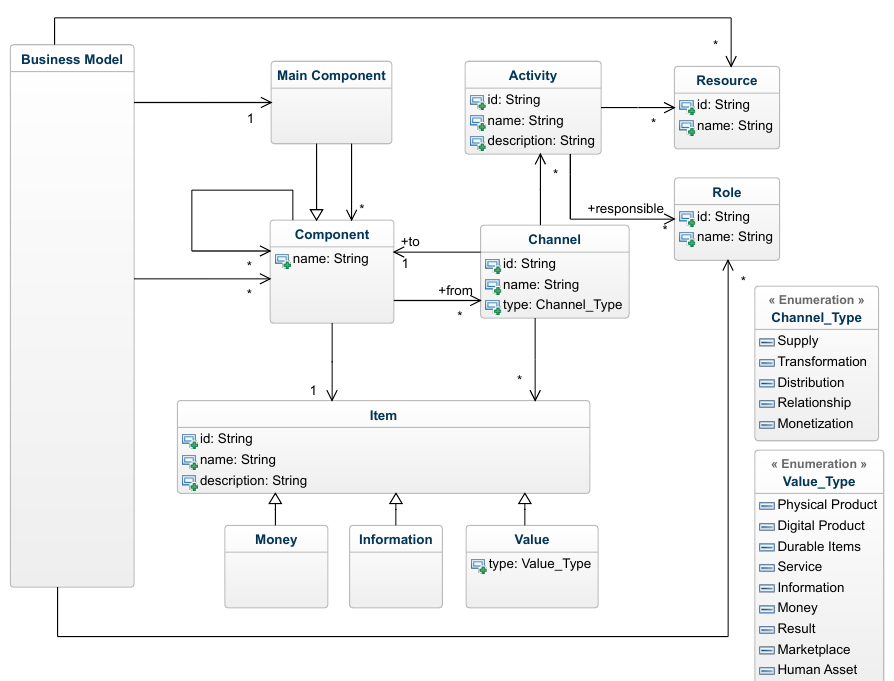
Figure 10. Novel Complex Business (NCB)